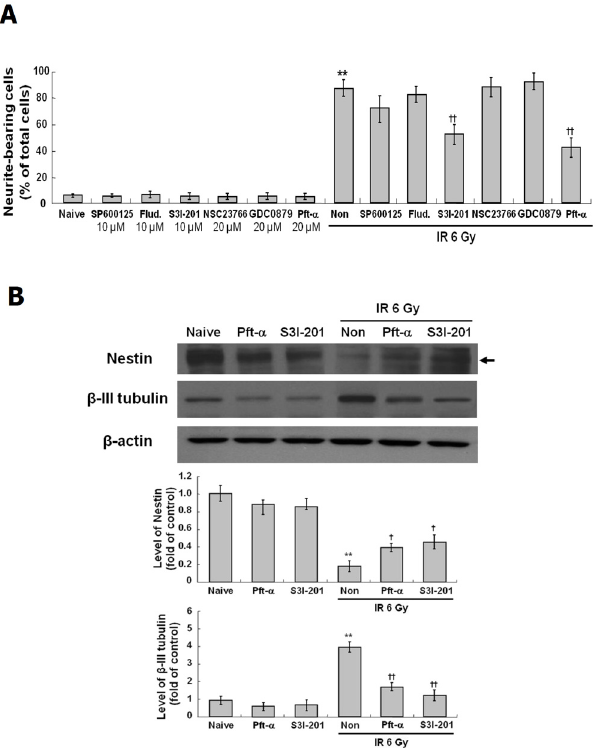
Fig 5. Effect of STAT3 and p53 inhibitors on IR-induced neuronal properties in C17.2 cells. C17.2 cells were treated with the inhibitors of JNK (SP600125) at10 μ M, STAT1 (Fludarabine) at 10 μ M, STAT3 (S3I- 201) at 10 μ M, Rac (NSC23766) at 20 μ M, B-Raf (GDC-0879) at 20 μ M and p53 (Pft- α ) at 20 μ M for 2 hr, and then exposed to IR at 6 Gy and incubated at 37°C for 72 hr. To assess rate of neurite bearing cells, each 200 cells in three randomly taken images were analyzed by Image J software. IR-induced neurite outgrowth is not affected by the inhibitors of JNK, STAT1, Rac and B-Raf but was blocked by the STAT3 inhibitor, S3I-201 and the p53 inhibitor, Pft- α (A). Expression of NSC marker, nestin, and neuronal marker, β -III tubulin was analyzed by Western blot (B, upper panel), and then quantified by Image J software (B, down panel). ** p < 0.01 vs naive group, † p < 0.05, †† p < 0.01 vs radiation only